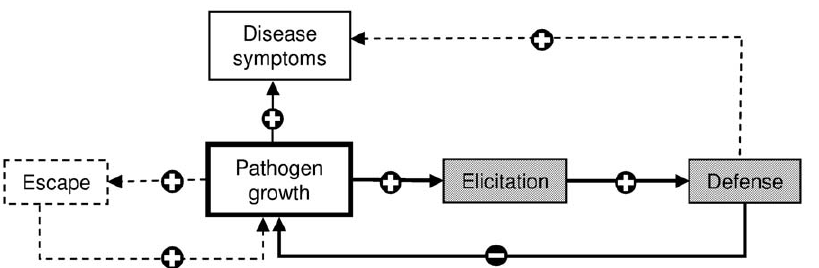
Figure 8. A general interaction model coupling physiological response with key life history traits of the pathogen. The model revolves around a key life history trait, pathogen growth, which drives both physiological (light shaded boxes and bold solid lines) and demographic responses (white boxes and dotted lines). The physiological part of the model derives from the PAMP-triggered response model [5]. It is assumed to occur in all pathosystems; however, defense reactions can also lead to enhance necrosis, and hence to enhanced symptoms of disease – as is the case in Phytophthora infestans (dotted lines). Pathogen growth varies between pathosystems, according to host exploitation strategies. In all cases, enhanced pathogen growth leads to more disease; however, in biotrophic pathogens like P. infestans , which reproduce on living tissue, growth can lead the pathogen to escape tissue before effective defense reactions take place. This model explains why although the PAMP-triggered response model probably works in all cases, opposite relationships can be observed when plotting the intensity of defense reactions against host resistance (i.e. disease symptoms).